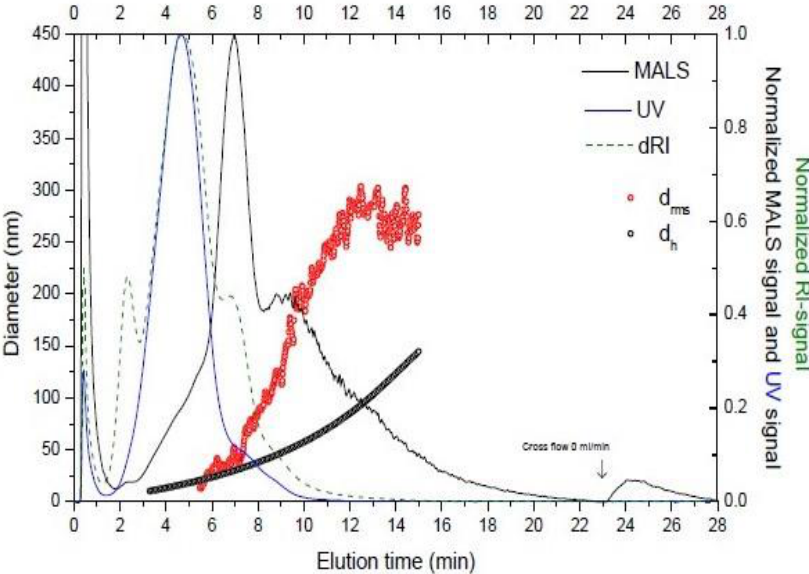
Figure 6. Elution profile of an EV sample. The graph shows the hydrodynamic diameter (dh, black open circles), the diameter of gyration (drms, red open circles). Signals are dRI (differential refractive index) (blue line), MALS (multi-angle light scattering) (black line), and UV signal (green dashed). The analysis was carried out at Solve Separation System, Wyatt Technology Europe, Dernbach, Germany), which was connected to a MALS